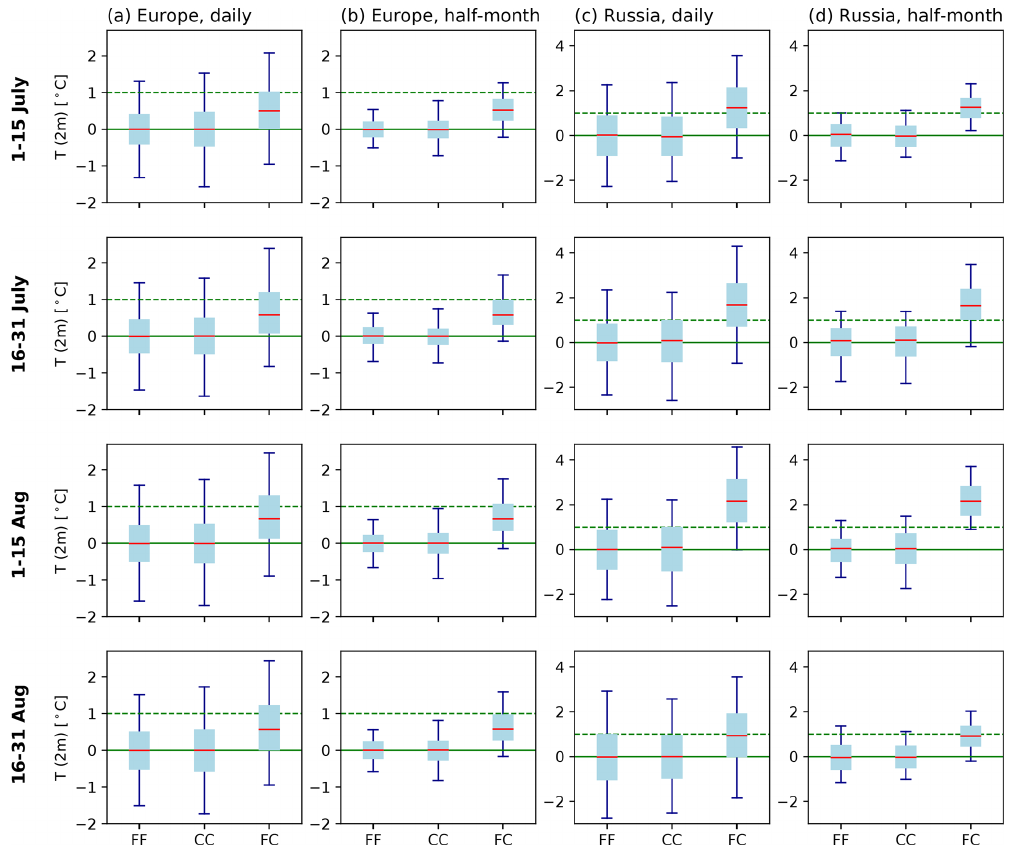
Figure 8. Distributions across grid points of differences between ensemble members in temperature at 2m height [ ◦ C], separated into the four half-monthly periods. FF: differences between pairs of factual members; CC: differences between pairs of counterfactual members; FC: differences between pairs of factual and counterfactual members. The boxes represent the 25th-to-75th-percentile range of the distributions, the red lines represent the 50th percentiles (the median), and the blue bars indicate the 5th-to-95th-percentile range. The dashed horizontal line indicates 1 ◦ C for reference. Columns (a) and (b) are for the European 2010 heatwave, and columns (c) and (d) for the Russian 2010 heatwave. Note the different vertical scales for the two events. Columns (a) and (c) show the differences in daily averages, and columns (b) and (d) show the differences in half-monthly